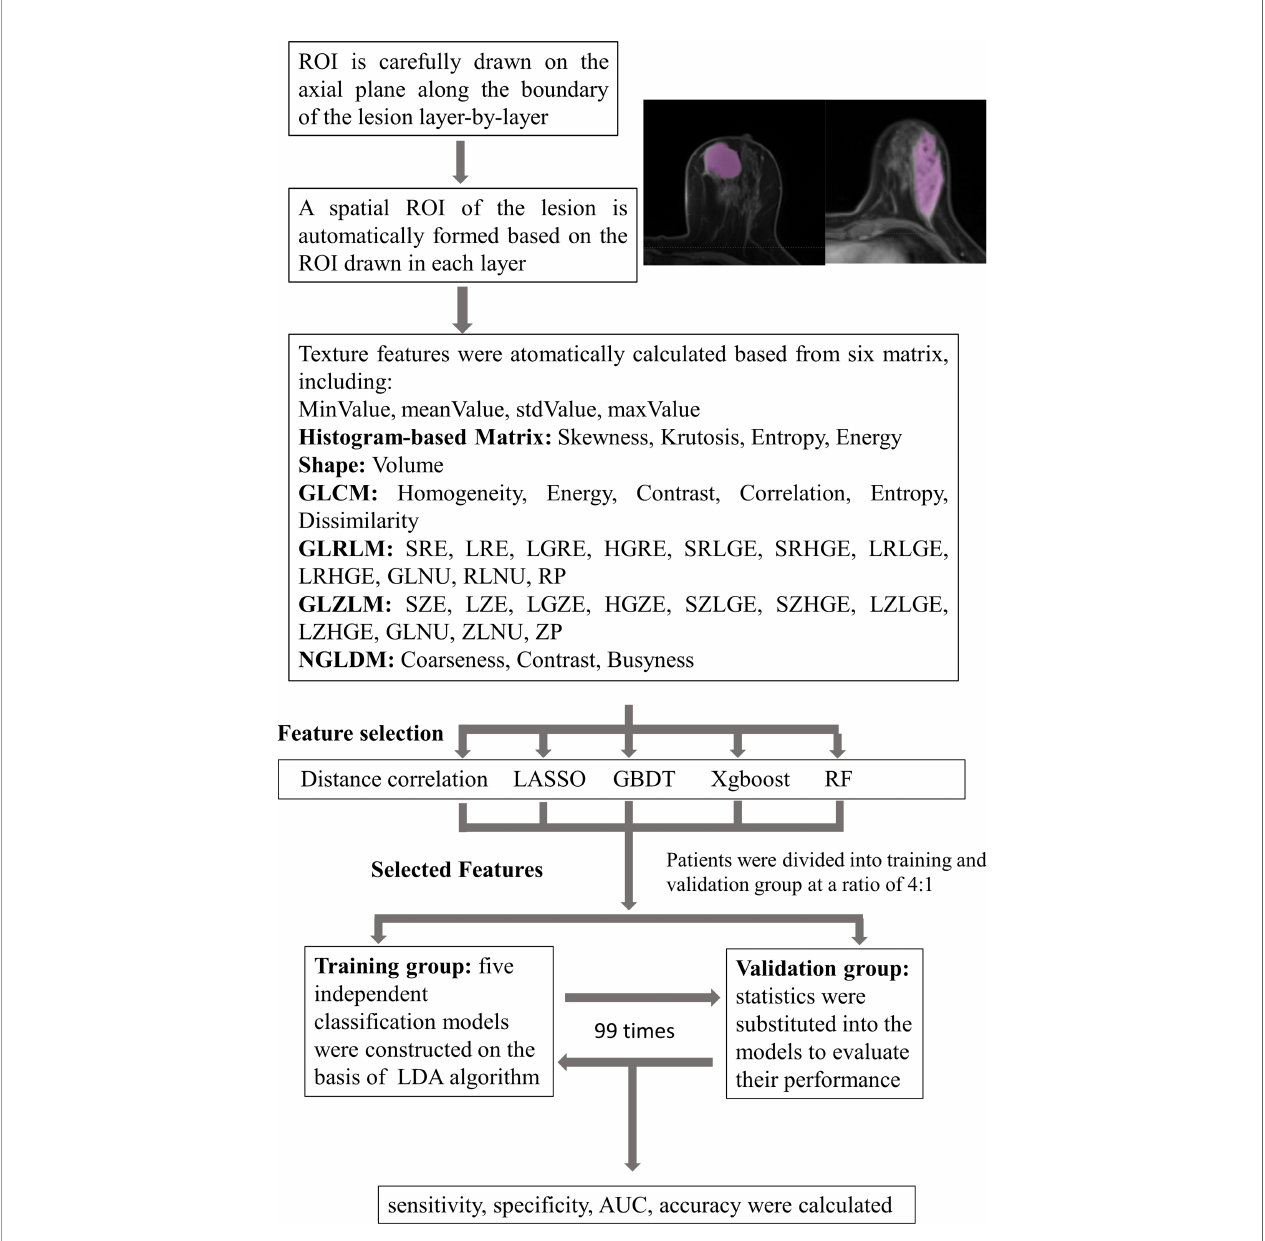
FIGURE 1 | Flowchart of the MRI classi fi cation process by different selection methods. ROI, region of interest; GLCM, gray-level co-occurrence matrix; GLRLM, gray- level run length matrix; GLZLM, gray-level zone length matrix; NGLDM, neighborhood gray-level dependence matrix; LASSO, least absolute shrinkage and selection operator; GBDT, gradient boosting decision tree; RF, random forest; LDA, linear discriminant analysis; AUC, area under the receiver operating characteristic